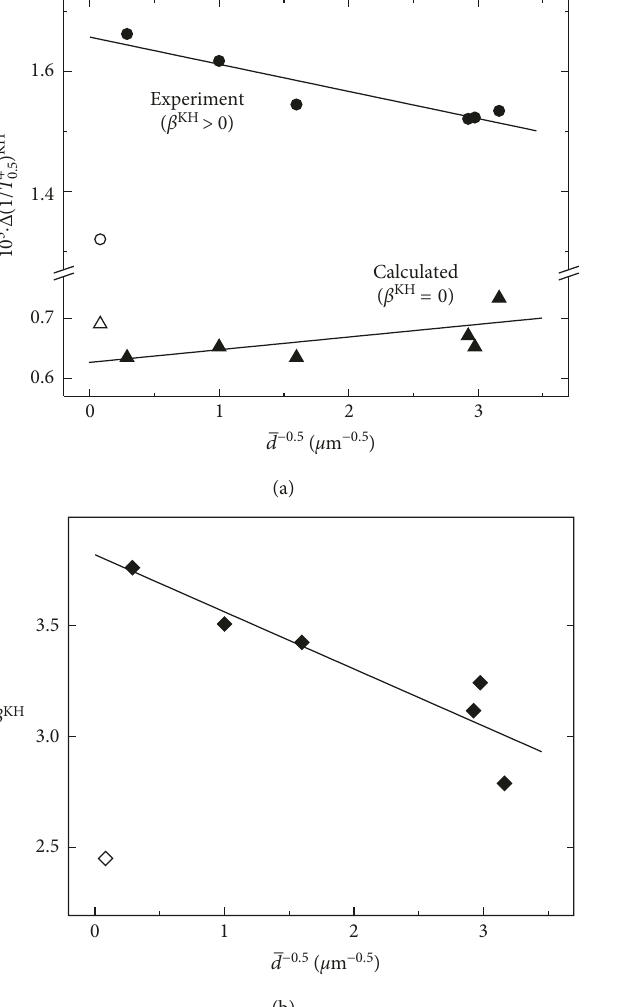
Figure 6: Dependences of (a) the experimentally measured width KH of the KH peak and calculated according to (14) for 1 /T 0 . 5 the case β 0 and (b) the distribution parameter β ∓ (cid:29) mean grain size d . Full symbols are the data of the present work; Δ ΚΗ open symbols are the processed data of the work [7]. Figure 7: Dependences on the parameter β of (a) the height of the